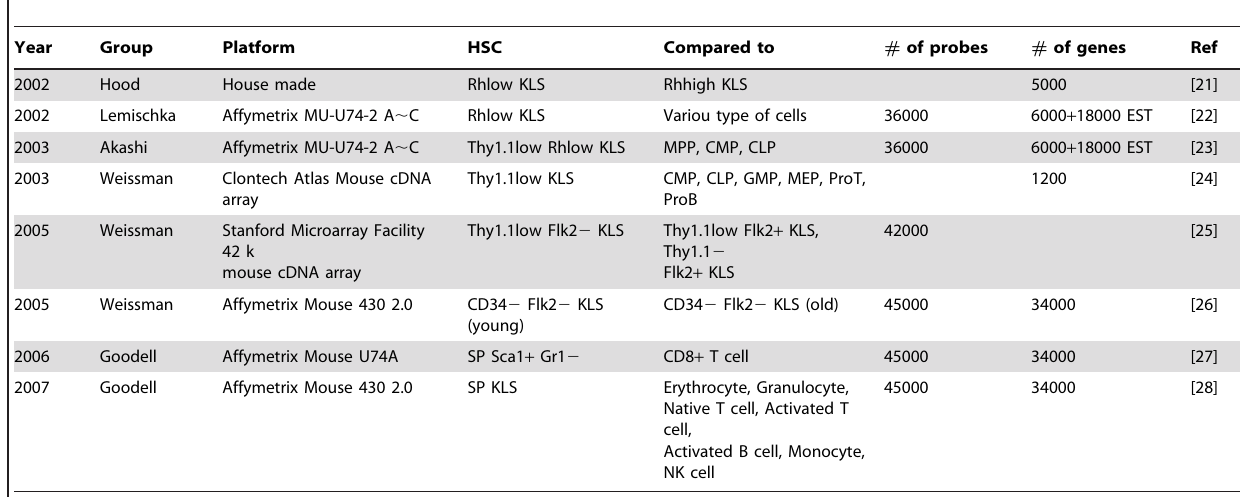
Table 4. Microarray gene expression profilings tageting HSC based on relative